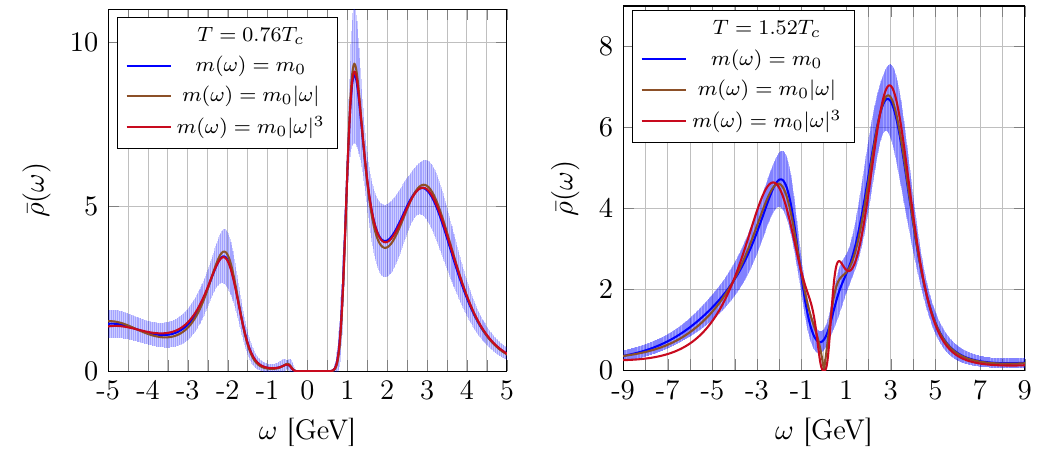
Figure 9 . Default model dependence in the nucleon channel at T=T c = 0 : 76 (left) and 1.52 (right). For clarity error bands are shown for one default model